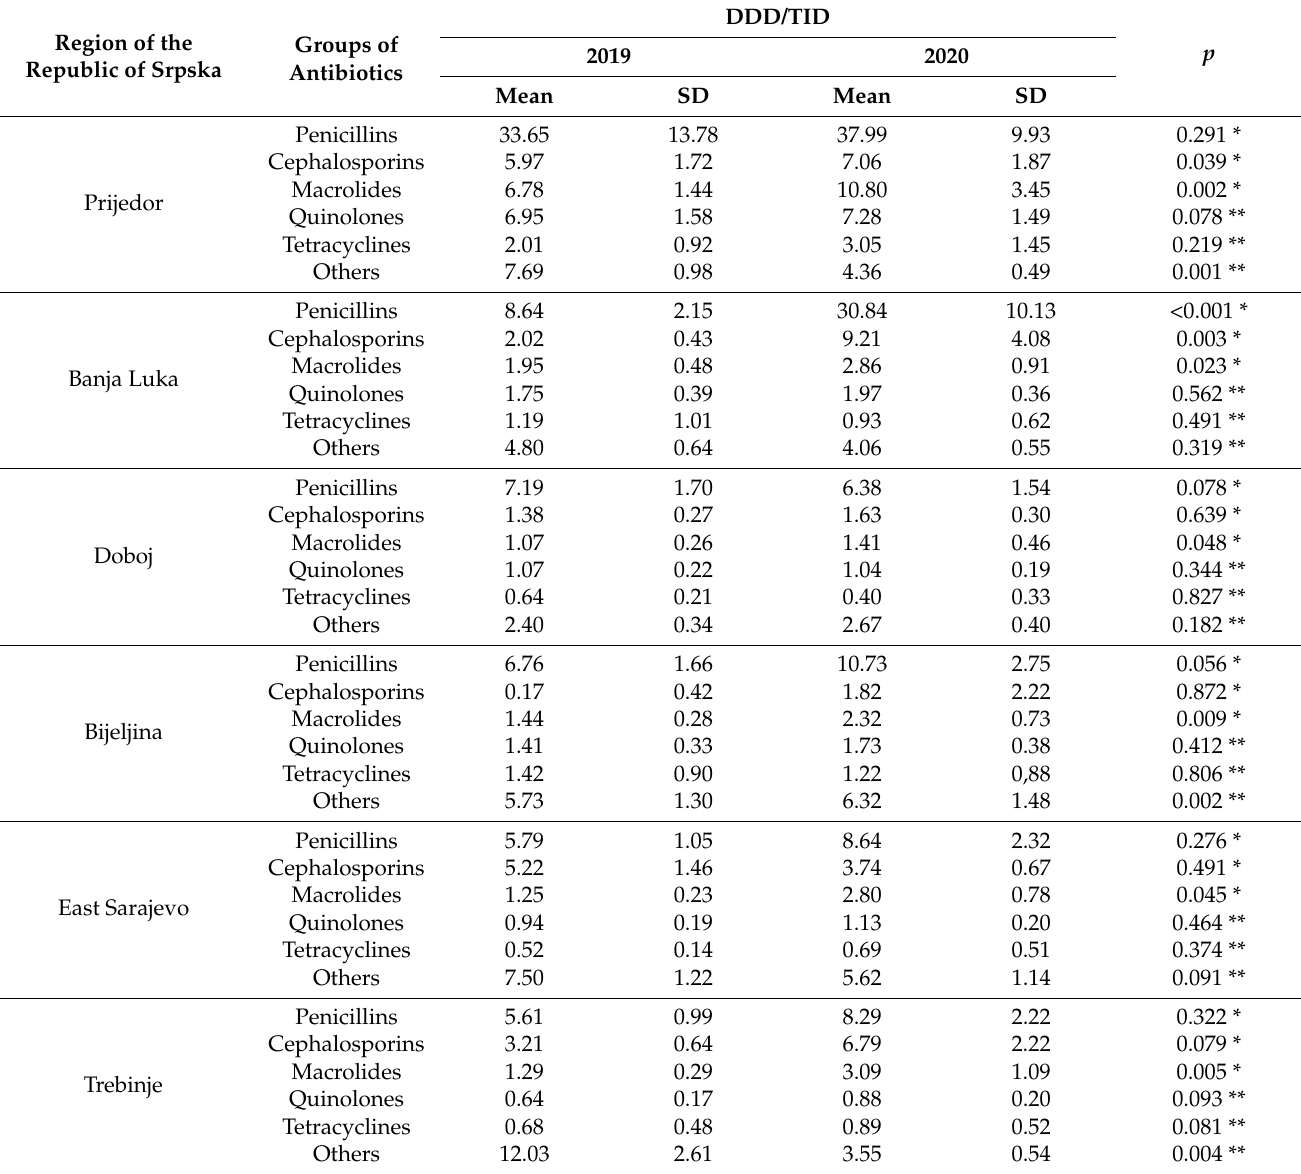
Table 3. Defined daily dose per 1000 inhabitants for penicillins, cephalosporins and macrolides use in outpatients, before (2019) and during (2020) pandemic period in RS.